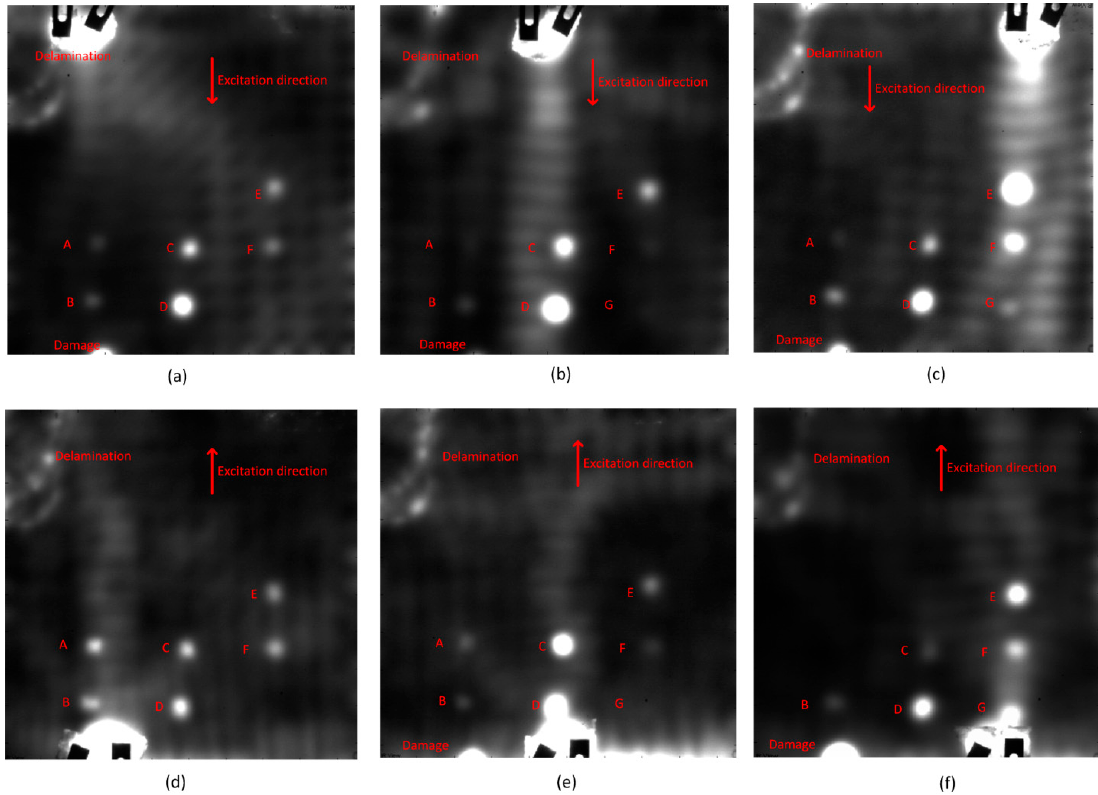
Figure 8: The complete vibrothermography results after CIS, (a) left ‐ top, (b) middle ‐ top, (c) right ‐ top, (d) left ‐ Figure 8. The complete vibrothermography results after CIS: ( a ) Left-top; ( b ) Middle-top; ( c ) Right-top; bottom, (e) middle ‐ bottom, (f) right ‐ bottom. ( d ) Left-bottom; ( e ) Middle-bottom; ( f )